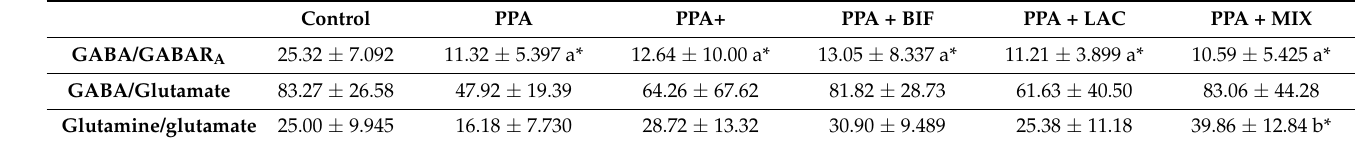
(a) Control vs. all groups, (b) PPA vs. all groups, (c) PPA + vs. therapeutic group, (d) PPA + BIF vs. PPA + LAC and PPA + BIF vs. PPA + MIX, and (e) PPA + LAC vs. PPA + MIX. (*) The mean difference is significant at p < 0.001, and (**) the mean difference is significant at p < 0.0001. Table 2. Means ± SD of all the measured variables. Ratios of (I) GABA/GABARA, (II) GABA/glutamate, and (III) glutamine/glutamate in the brain homogenates of the six studied groups.